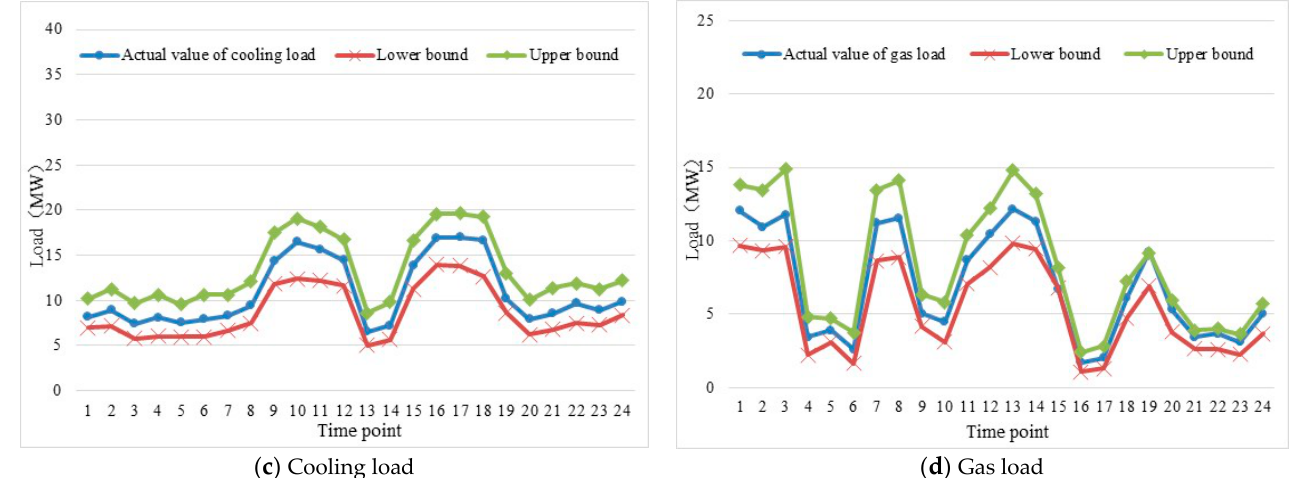
Figure 14. Multi-energy load forecast results on the holiday based on the STL method. Table 2. Prediction performance comparison of two models with the STL method and the MTL method.